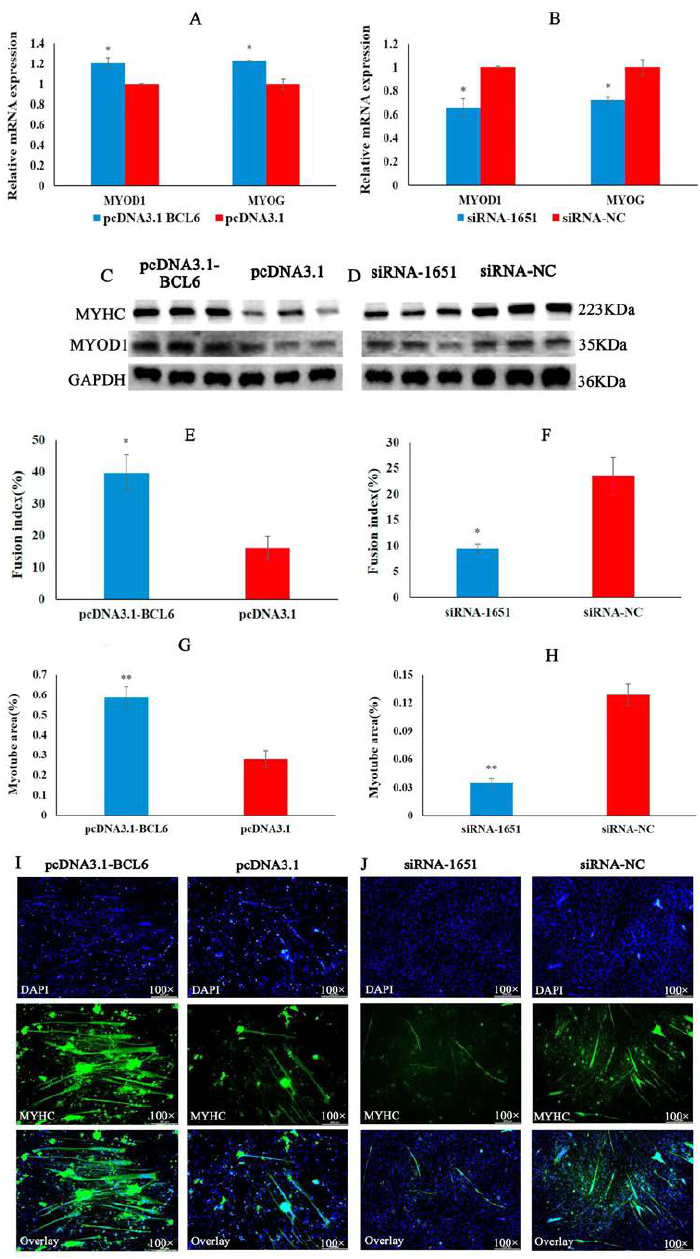
Figure 6. BCL6 gene promotes chicken myoblasts’ differentiation. ( A , B ) The results of qRT-PCR for differentiation marker genes MYOD1 and MYOG after transfection with pcDNA3.1-BCL6 and siRNA-1651. ( C , D ) The protein expression of MYHC, MYOD 1, and GAPDH after transfection with pcDNA3.1-BCL6 and siRNA-1651. ( E , F ) The fusion index (%) of chicken myoblasts after transfection with miRNA-10a-5p mimic and inhibitor. ( G , H ) The statistical results of the myotube area of myoblasts after transfection with pcDNA3.1-BCL6 and siRNA-1651. ( I , J ) The results of IFA after transfection with pcDNA3.1-BCL6 and siRNA-1651. In all graphs, the results are shown as mean ± SEM (standard error of the mean) ( n = 3). * p < 0.05, ** p <